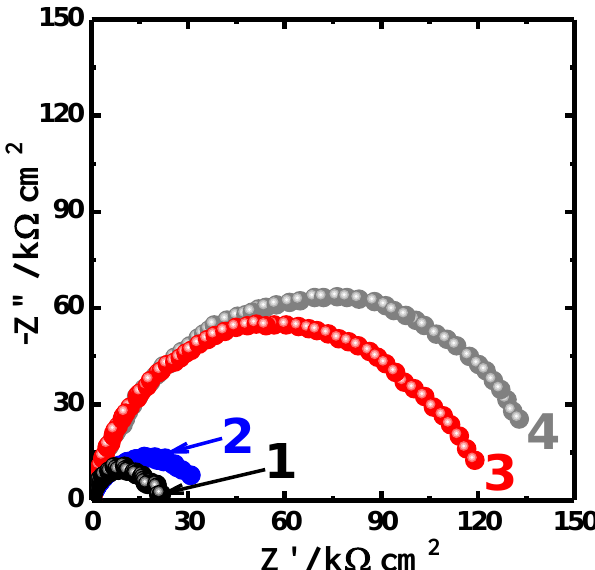
Figure 4. Nyquist spectra for 6061 alloys, ( 1 ) the as received and the extruded alloys at ( 2 ) 350, ( 3 ) 425, and ( 4 ) 500 °C after the immersion in 3.5% NaCl solutions for 24 h.